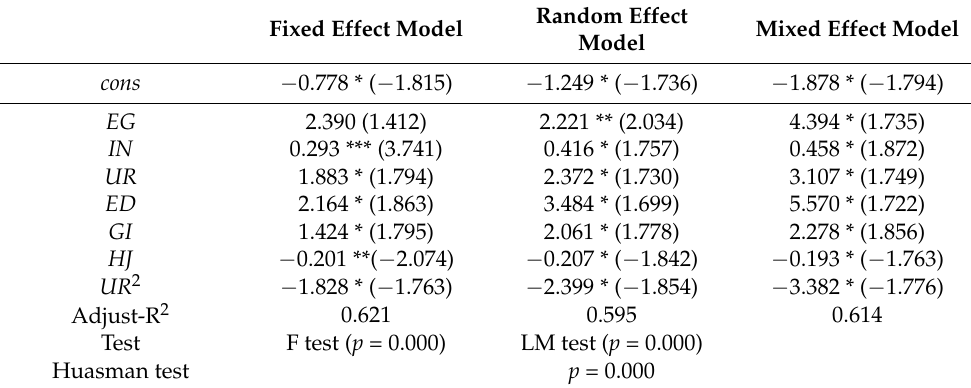
Table 8. Regression